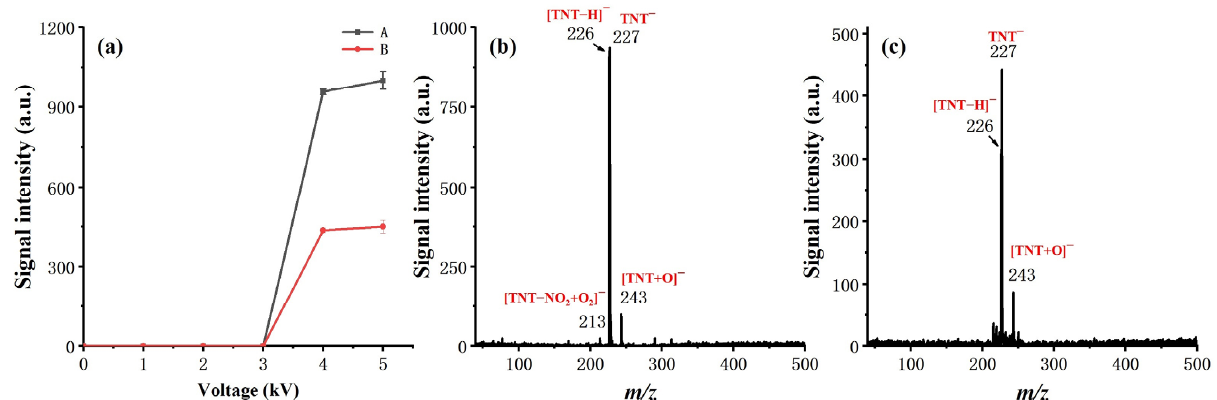
Figure 4. Effect of discharge polarity and voltage, measured by a signal intensity of 1 ng TNT. ( a ) Curve A: HV is applied on the inner electrode; curve B: HV is applied on the outer electrode; ( b ) Mass spectrum of 1 ng TNT, to which HV is applied on the inner electrode; ( c ) Mass spectrum of 1 ng TNT, to which HV is applied on the outer